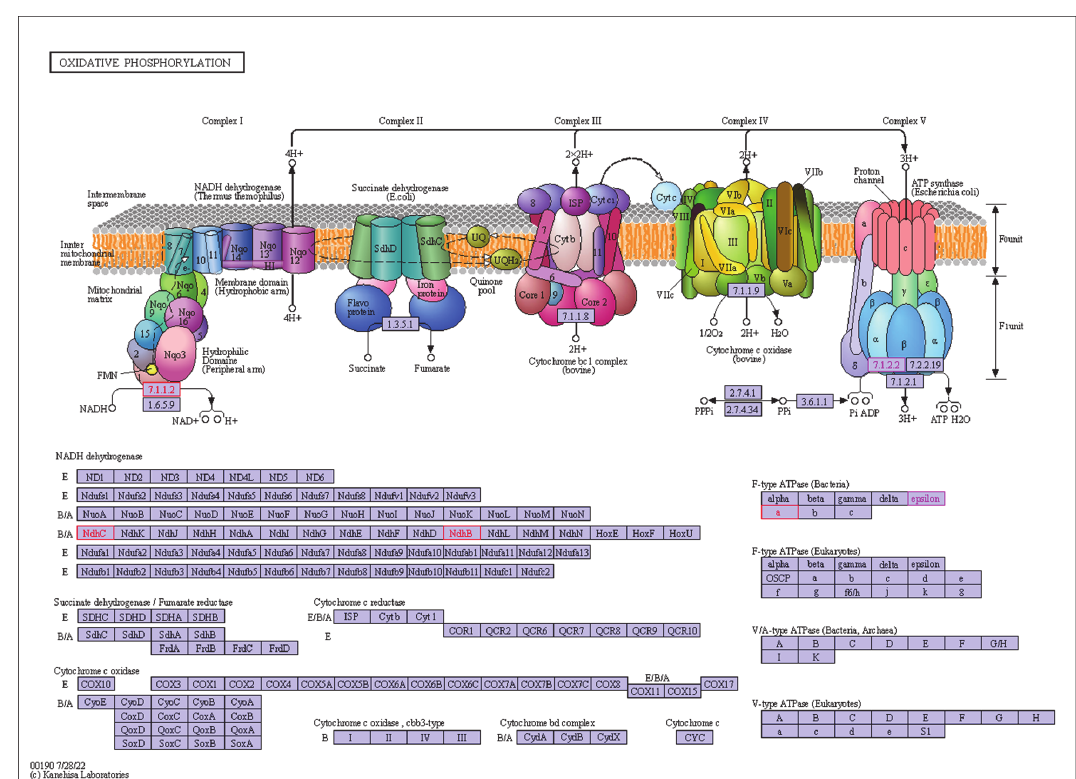
Plants 2022 , 11 , x FOR PEER REVIEW Figure 13. Details of Oxidative phosphorylation pathway. Figure 13. Details of Oxidative phosphorylation pathway.